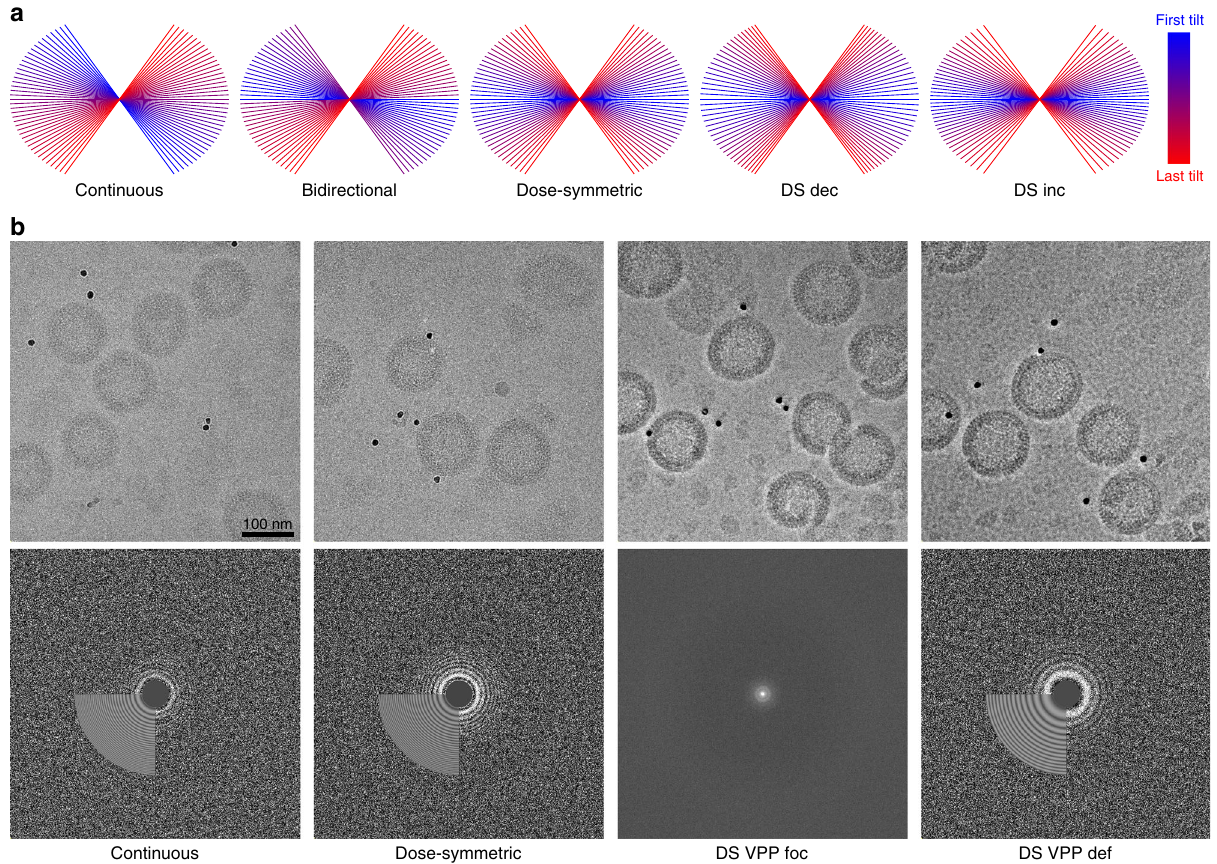
Fig. 1 Visualization of the acquisition schemes. a Overview of different angular acquisition schemes used. b Zero-degree projections from representative tilt-series and their corresponding periodograms with fi tted CTF model estimated by CTFFind4. For DS VPP foc scheme a conventional Fourier power spectrum is shown. Table 1 Comparison of average times needed for an acquisition of one tilt-series containing 41